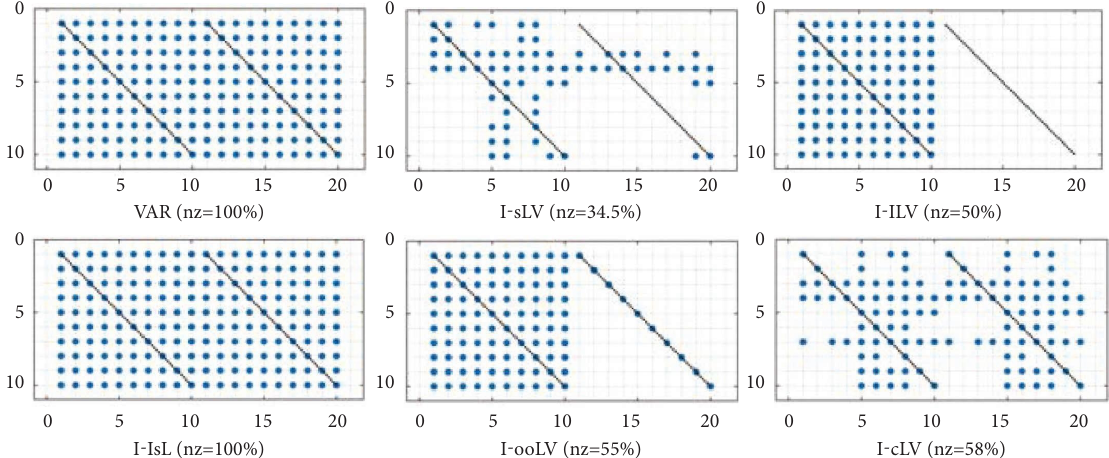
Figure 3: Sparsity structure of coefcients matrix for frst lead